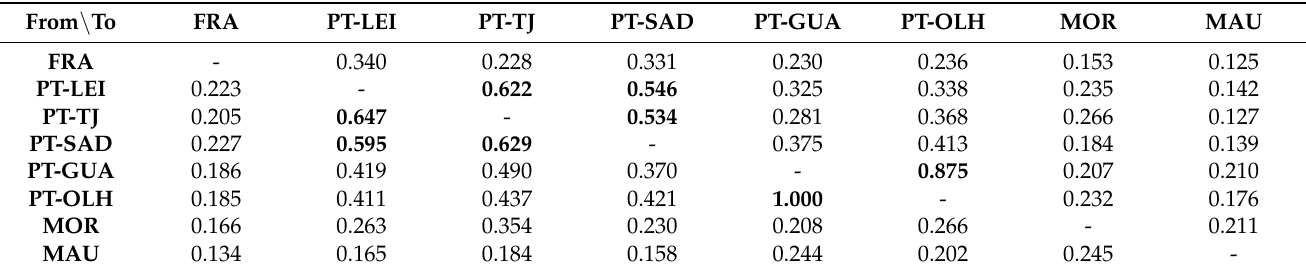
Figure 4. Relative migration network among Argyrosomus regius Atlantic location sites. Arrows indicate direction of gene flow and respective percentage of migration (Nm value). For location sites’ acronyms, please check Table 1 . Table 7. Estimates of migration percentage (Nm values, i.e., estimates of the gene flow from the location site in the rows to the location site in the columns; ranges between 0 and 1) among Argyrosomus regius Atlantic location sites. Values of Nm higher than 0.500 are displayed in bold. For location sites’ acronyms, please check Table 1 .